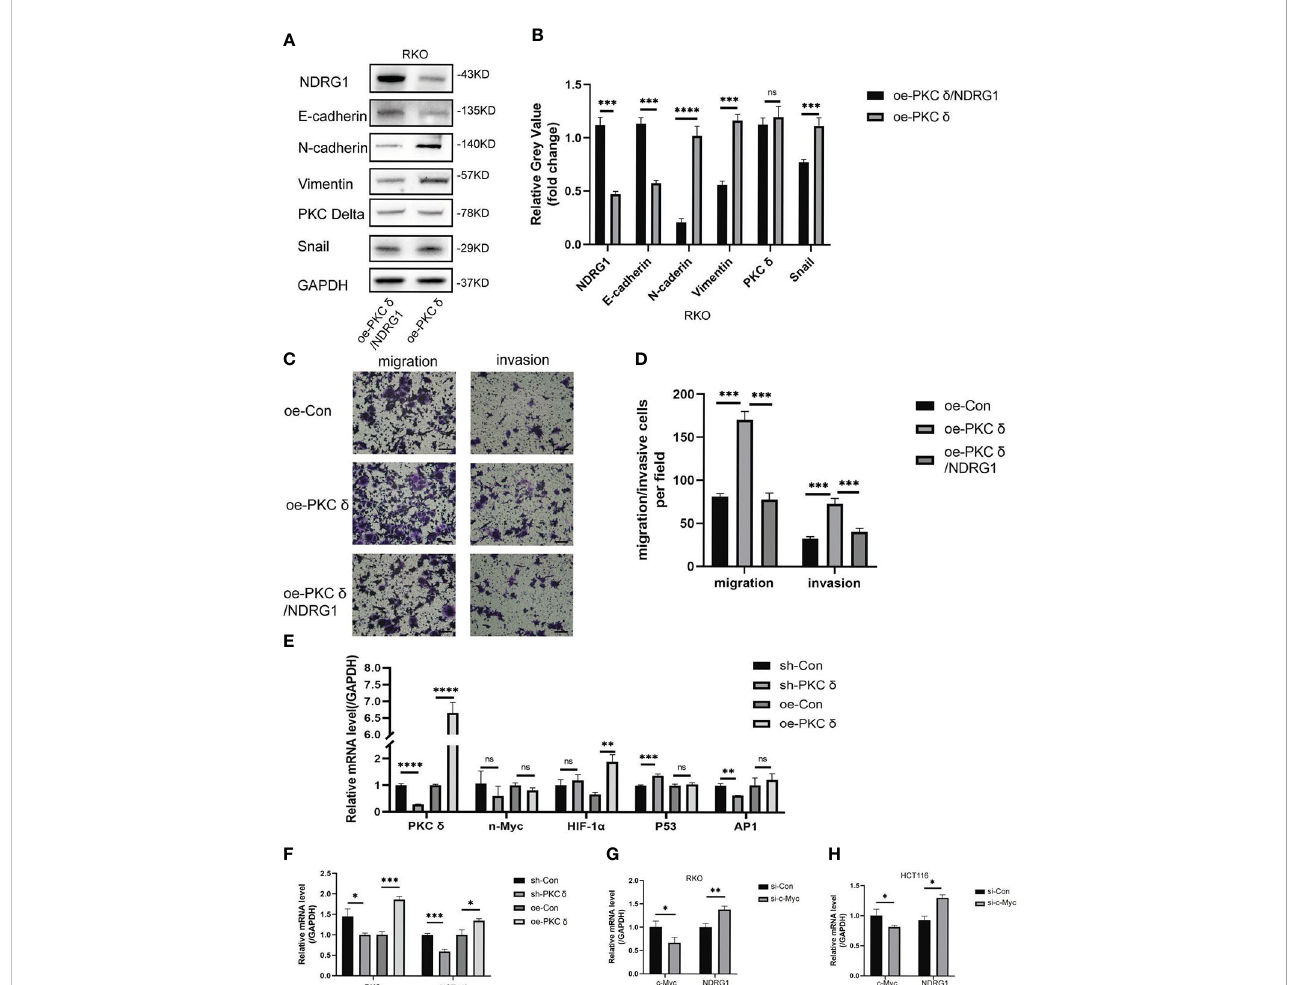
FIGURE 7 PKC d down-regulated NDRG1 by promoting c-Myc expression. (A) Overexpressing PKC d and NDRG1 downregulated the mesenchymal marker N- cadherin, Vimentin, and Snail and upregulated the epithelial marker E-cadherin in RKO cells, determined by Western blots. (B) Columns were used to quantify the protein expression levels in (A) relative to GAPDH. (C) PKC d and NDRG1 overexpression inhibited the invasion and migration of RKO cells, detected by cell invasion and migration assay. (D) Columns were used to quantify the migrated and invasive cells in (C) . (E) The relationship between PKC d and P53, AP-1, HIF-1 a , or n-Myc in RKO cells, determined by qPCR. (F) The relationship between PKC d and c-Myc in RKO and HCT116 cells, determined by qPCR. (G) The effect of PKC d on the mRNA level of c-Myc in RKO cells, determined by qPCR. (H) The effect of PKC d on the mRNA level of c-Myc in HCT116 cells, determined by qPCR. Scale bar: 20 m m. *p < 0.05, **p < 0.01, ***p < 0.001, ****p < 0.0001. ns, no signi fi